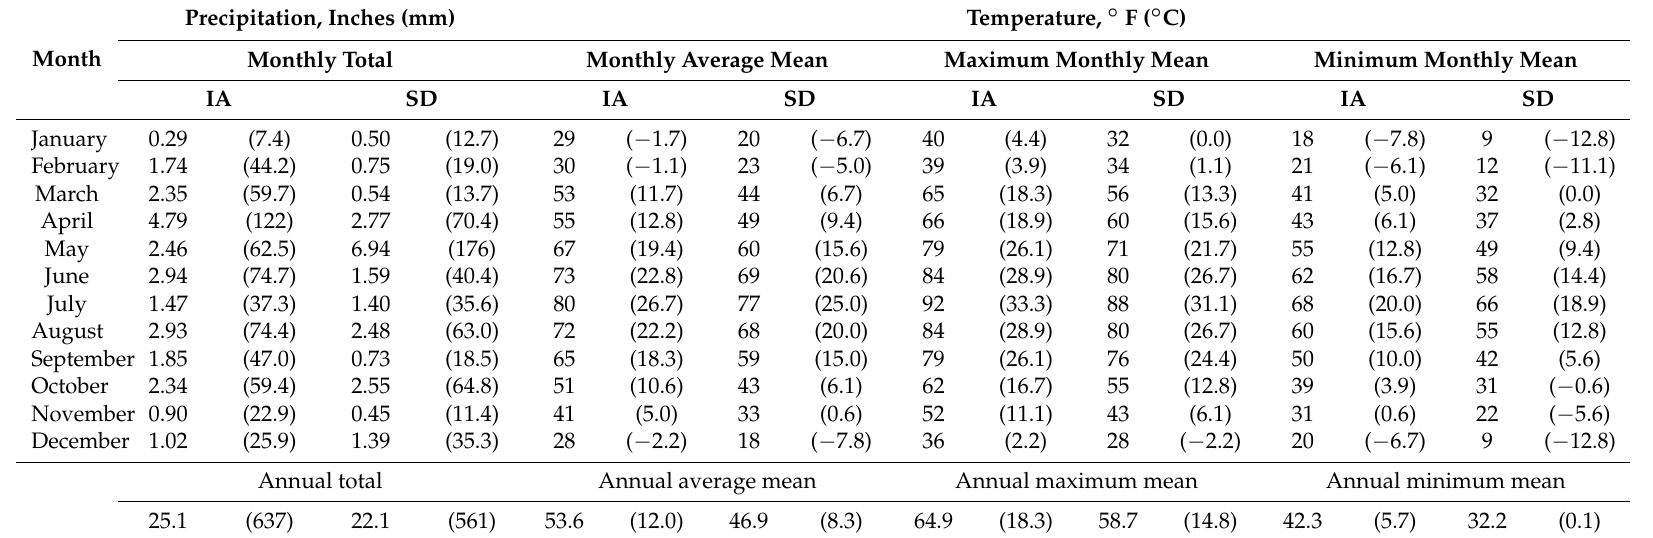
Table 1. 2012 precipitation and air temperature data for Ames, IA and Brookings,